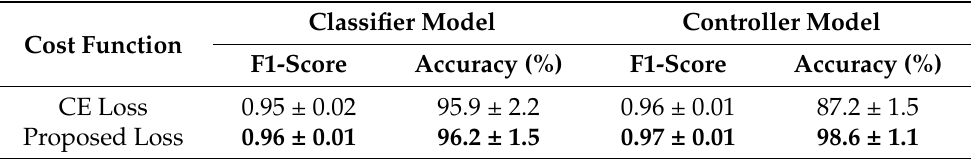
Table 8. Comparison of the effect of CE and proposed loss on the classifier and controller models when trained for 100 epochs. The results are taken on the test sets (mean ±